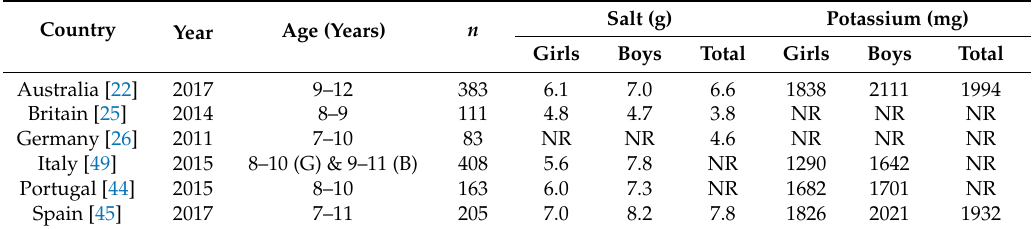
Table 4. Previous studies examining twenty-four hour urinary electrolyte excretion overall and by sex in children aged approximately seven to 11